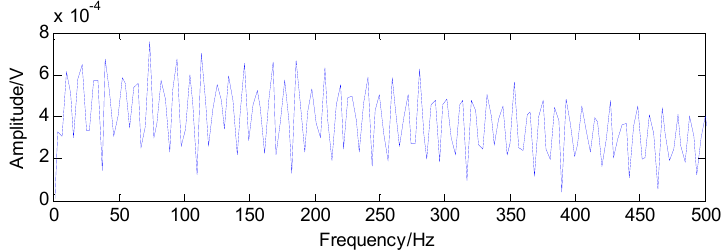
Figure 14. Envelope spectrum of the transient impact component in Figure 11.